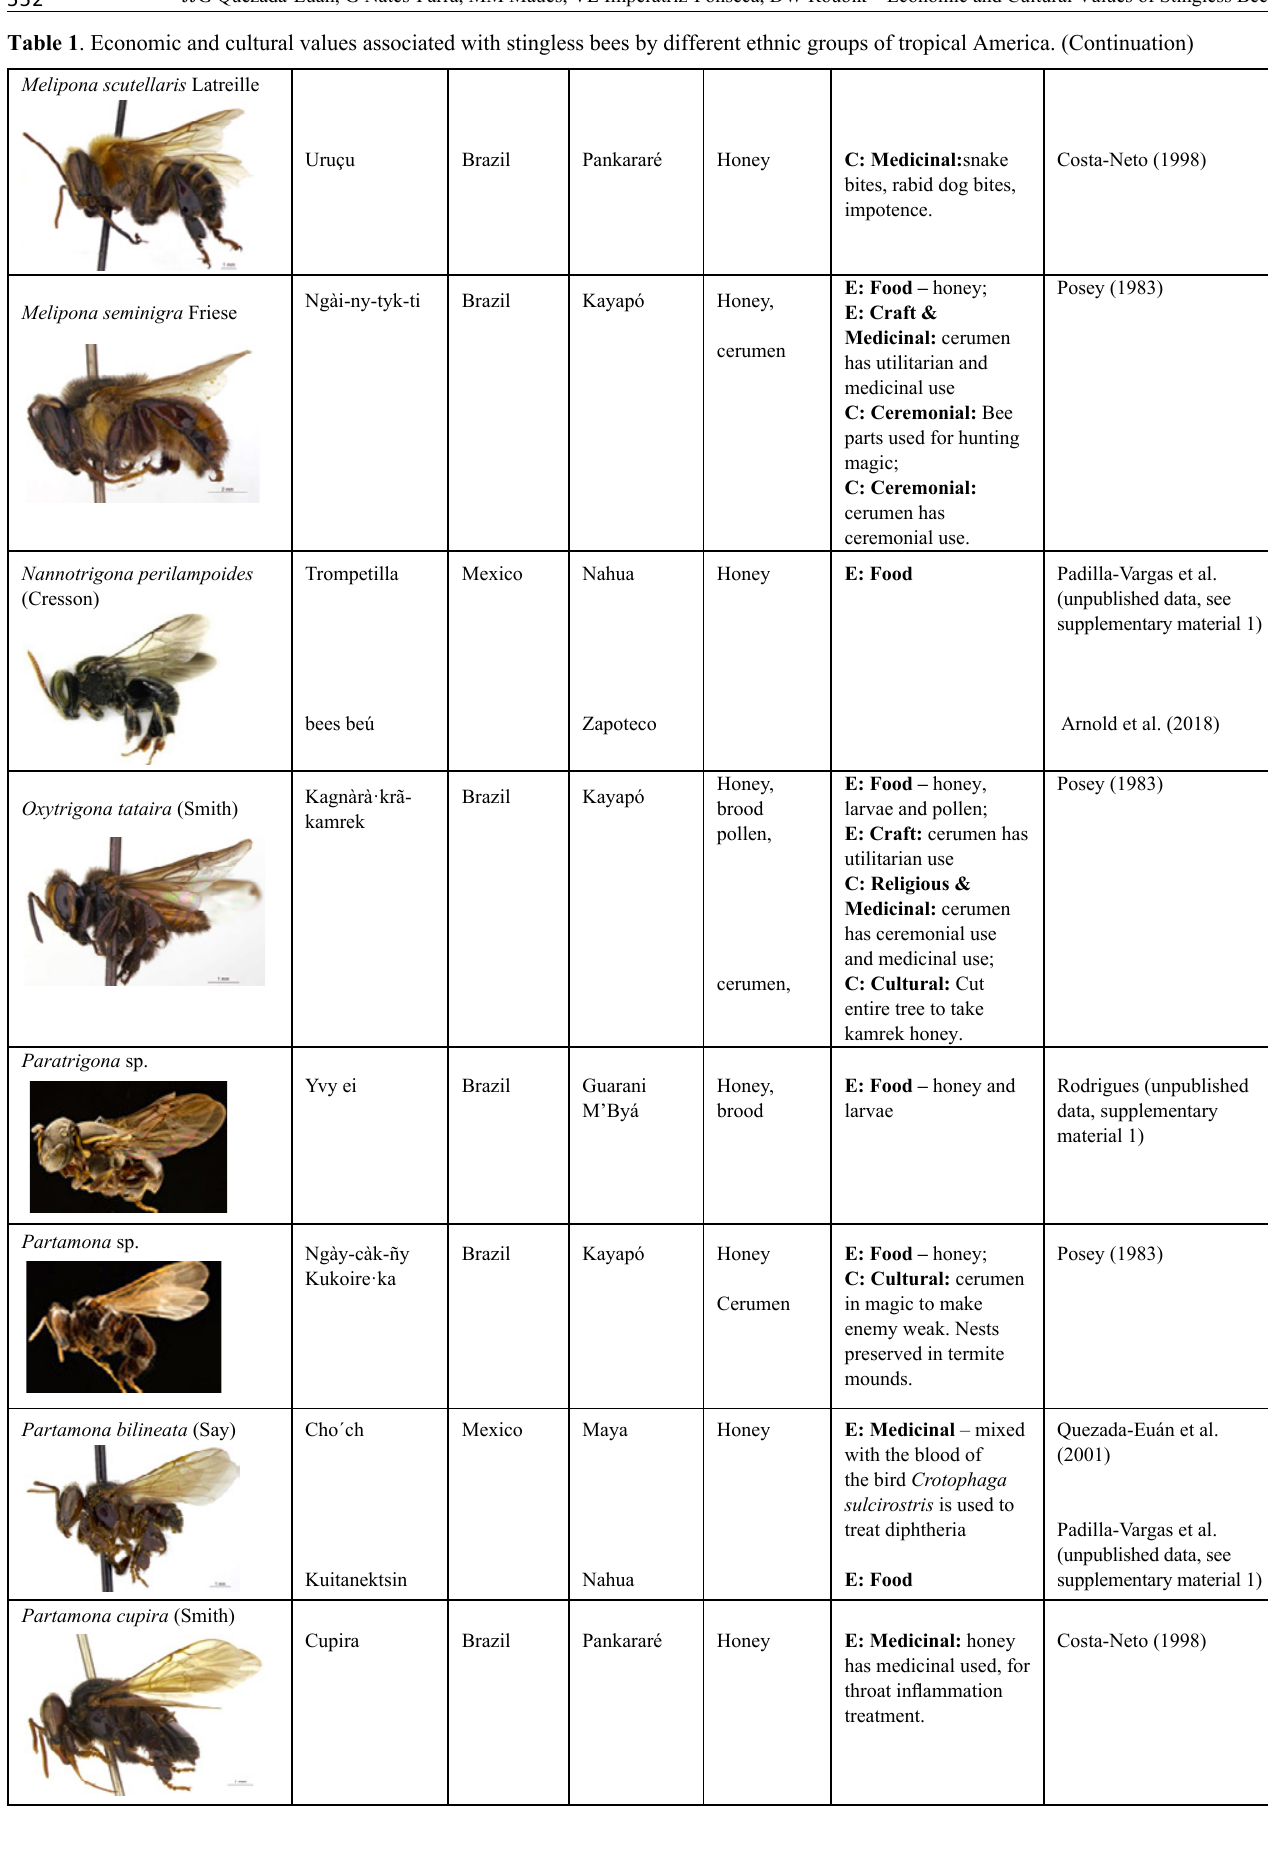
Table 1 . Economic and cultural values associated with stingless bees by different ethnic groups of tropical America.